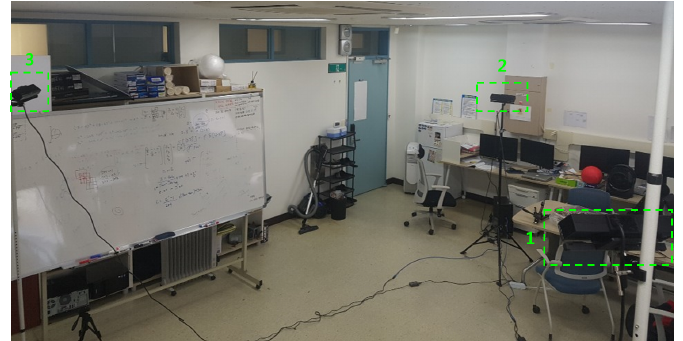
Figure 12. Our Kinect v2 camera